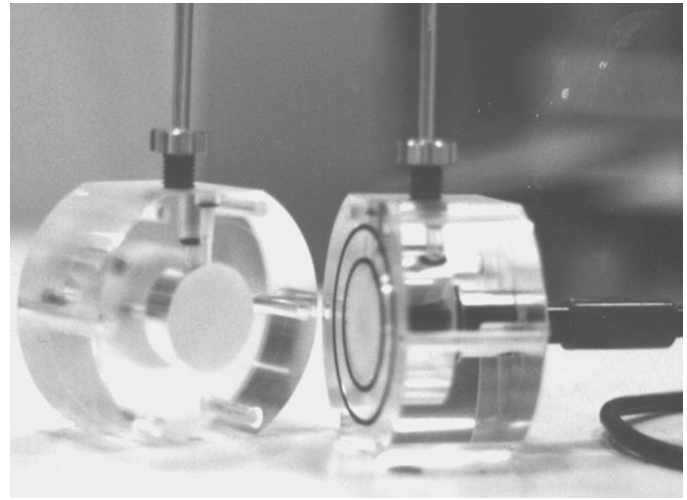
Figure 3. A photograph of the osmotic cell opened to reveal the porous sinters.